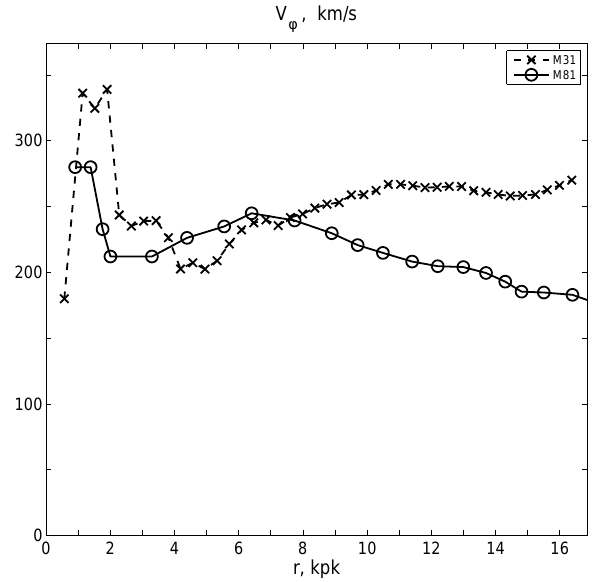
Figure 1. Observed rotation curves of galaxies having velocity jump in the inner disk region: M31 – crosses on a dashed line (Chemin et al. 2009); M81 – circles on a solid line (Tenjes et al. 1998).